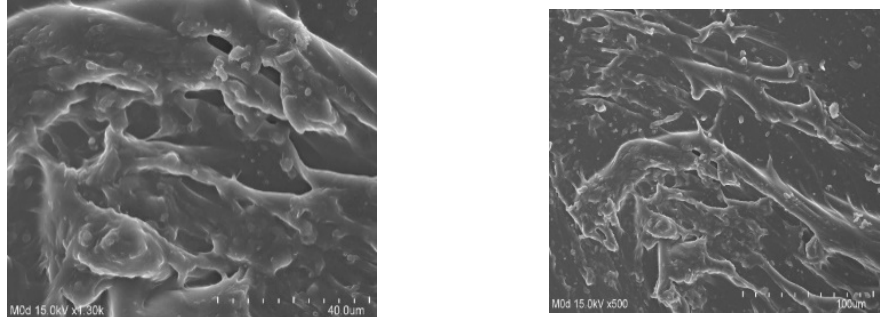
11 of 21 Figure 6. XRD of CS, CP, PVA, CS/CP/PVAcPAa hydrogel, DS, and drug ‐ loaded CS/CP/PVAcPAa hydrogel. 3.6. SEM The microstructures and surface morphology of CS/CP/PVAcPAa hydrogel were in ‐ vestigated by SEM at different magnifications, as shown in Figure 7. Porosity and water retention capability of the hydrogel were evaluated by SEM. A rough surface with micro ‐ spaces through which water absorption and drug entrapment occurred was revealed by SEM images. The water absorption occurred through the micropores of the hydrogel, and, as a result, swelling of hydrogel was exhibited. Due to swelling, entrapment of the drug occurred. Furthermore, DS was entrapped easily by the formulated hydrogel because of the irregular surface and presence of pores. Thus, due to the existence of pores, which led